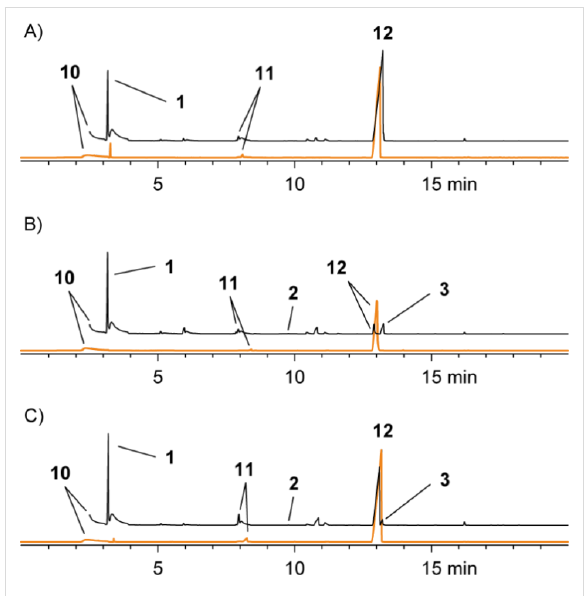
Figure 5: Chromatograms of headspace extracts from (A) R. pomeroyi DSS-3 wild type, (B) R. pomeroyi DSS-3 dmdA − , and (C) R. pomeroyi DSS-3 dddQ − after feeding of DMTeP by use of CLSA (black) and SPME